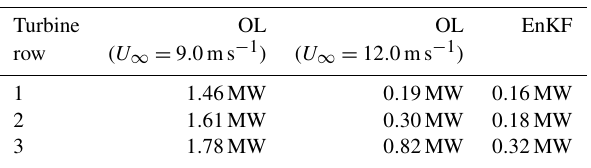
Table 5. Turbine-averaged RMSE in power time series of Fig. 9 (compared to SOWFA). The lower the RMSE, the better the fore-